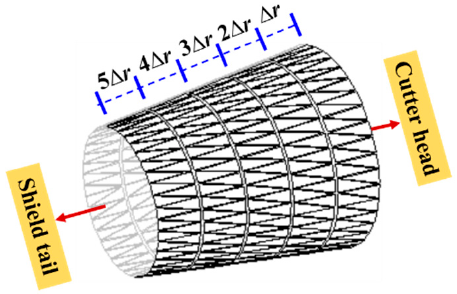
Figure 7. Conical shield shell (180-fold magnified).